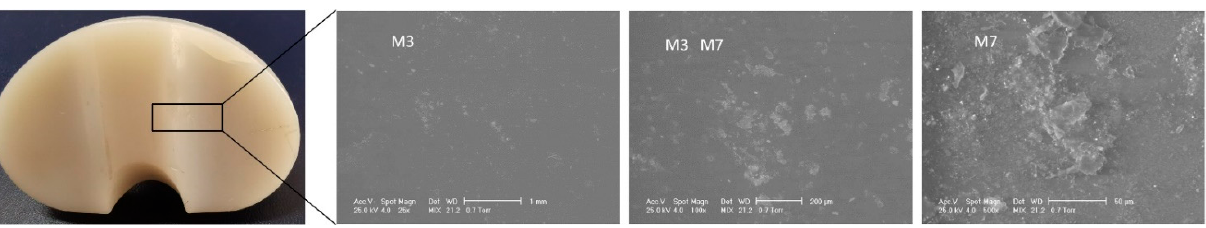
Figure 10. SEM images obtained for IT3 sample.